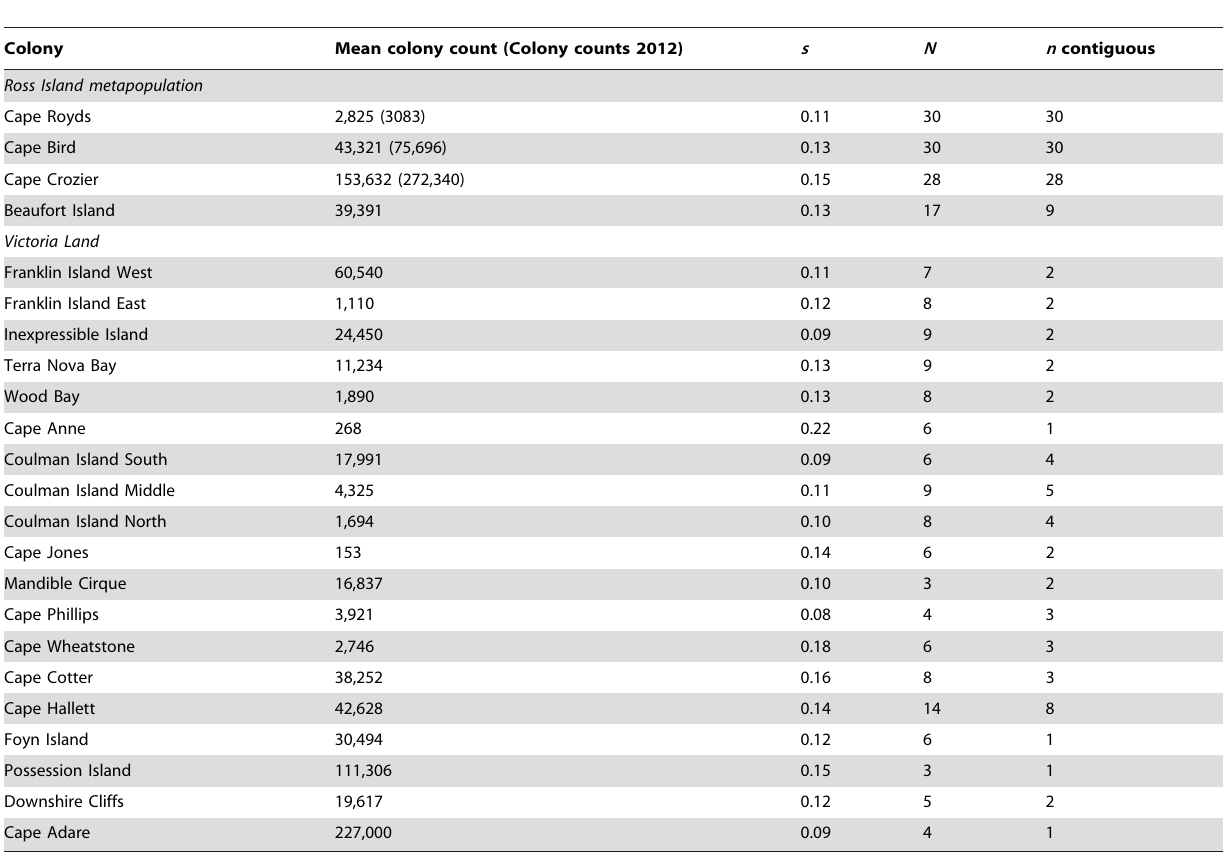
Table 1. Mean colony counts of nesting territories (with colony counts from Ross Island 2012 for comparison) and s , a measure of the amplitude of colony size variations ( n is the total number of counts per colony), for colonies in the southern Ross Sea metapopulation and along the Victoria Land coast between 1981 and